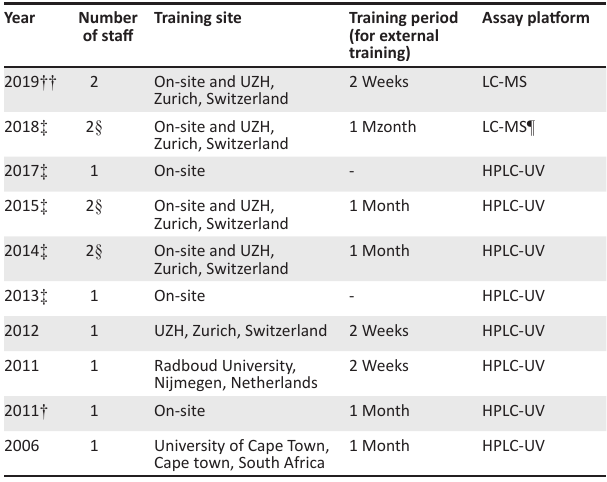
TABLE 1: Human resource training programmes conducted between 2006 and 2019.